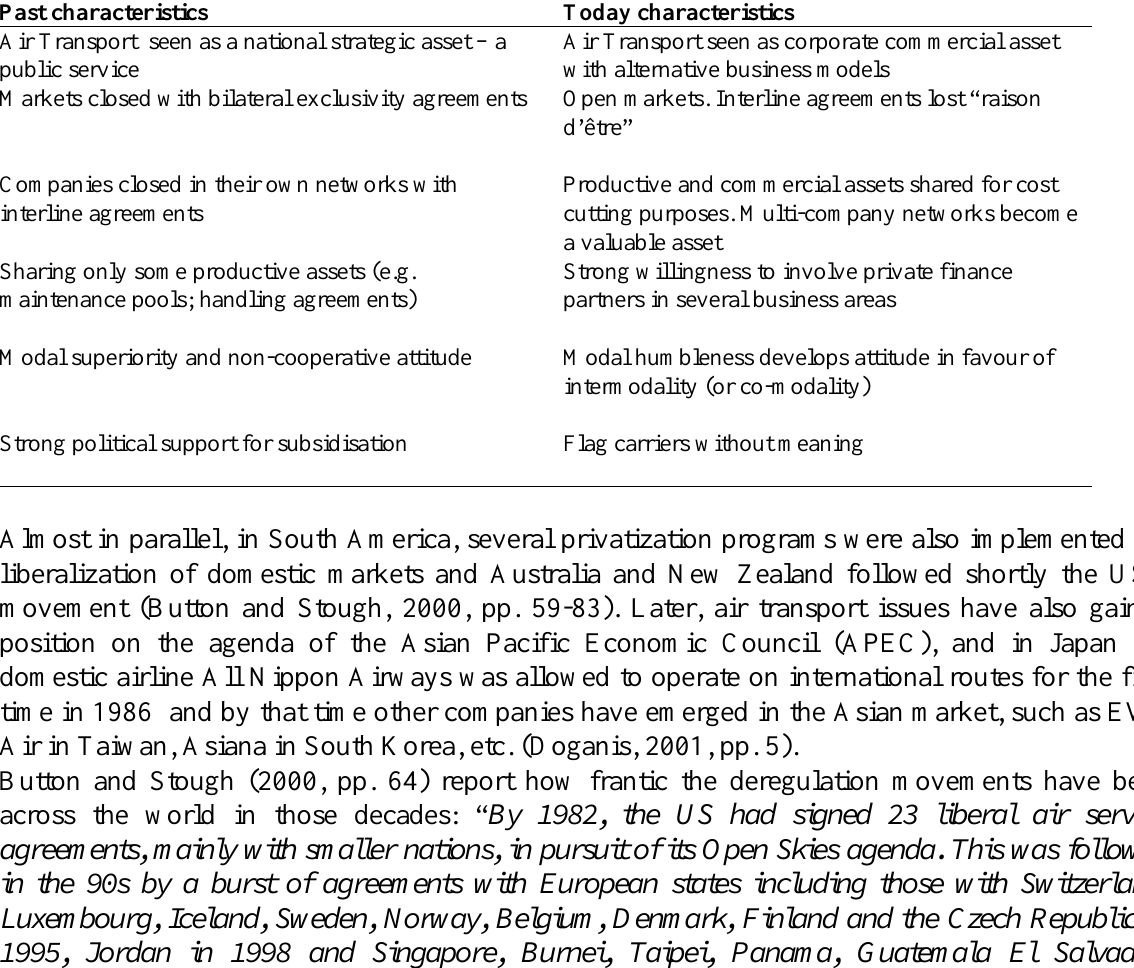
Table 1. Elements of differentiation of the industry before and after the 70’s Past characteristics Today